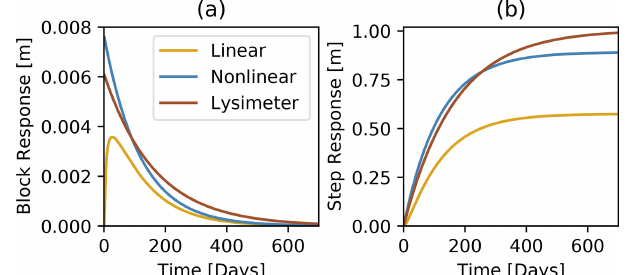
Figure 8. Calibrated block and step response functions for all three models. The block response (a) shows how the groundwater levels react to a 1d recharge event of 1mm. The step response (b) shows the response of the groundwater level to a sudden unit increase in recharge that extends infinitely in